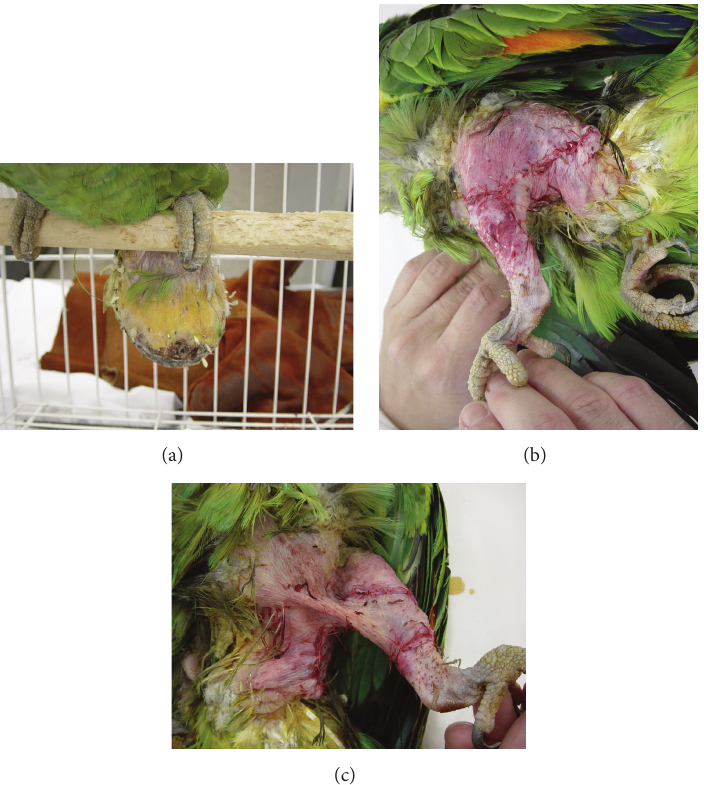
Figure 4: Case number 13: lipoma affecting the pelvic limb and pericloacal area ( Amazona sp . ). (a) Caudal, ulcerated, pendulum-like neoplasm.((b)and(c))Immediatepostoperativeappearance:skinclosureonthelateral(b)andmedial(c)aspectsofthepelviclimb,extending to the pericloacal area (simple interrupted sutures, 4-0 polyglactin